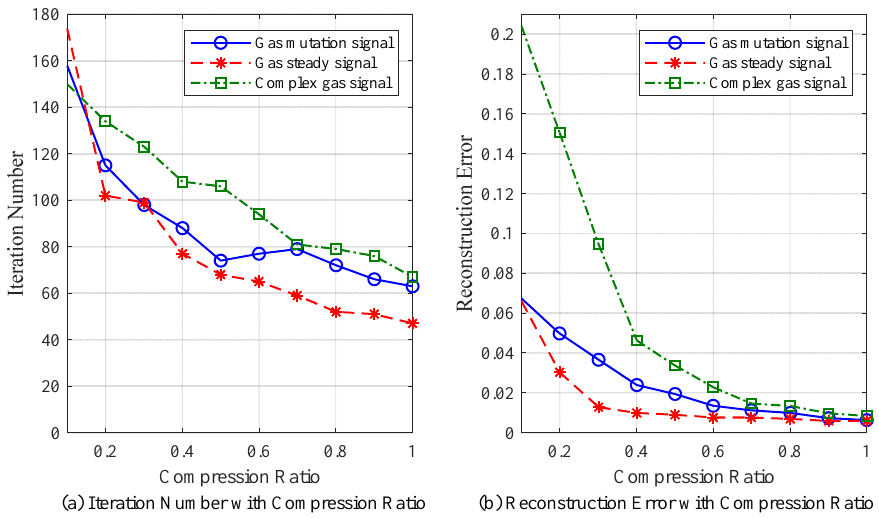
Figure 9. The relations of the compression ratio with the reconstruction error and iteration number for the reconstruction of three different gas signals using the TVS ‐ MH algorithm.